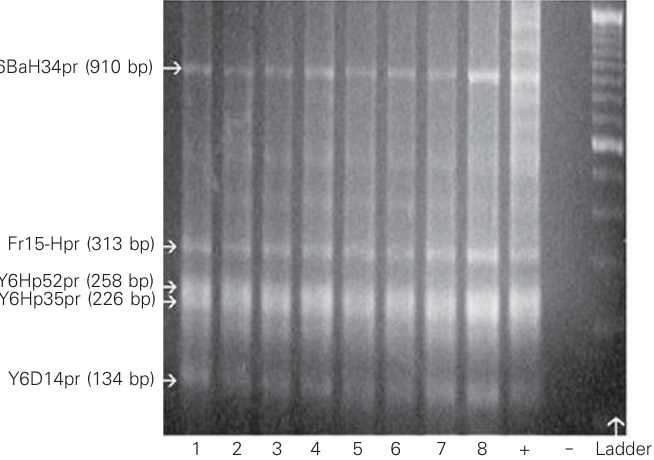
Figure 1. Amplification on 1.5% agarose gel of DNA extracted from touch and scrape liver preparatives at a concentration of 600 ng/µl. Lanes : 1 , SP95%; 2 , SPMA; 3 , SP95%; 4 , SPMA; 5 , TP95%; 6 , TPMA; 7 , TP95%; 8 , TPMA; +, positive control; - negative control; Ladder 100 bp. TP = touch preparatives; SP = scrape preparatives; 95% = 95% ethanol, MA = methanol:glacial acetic acid